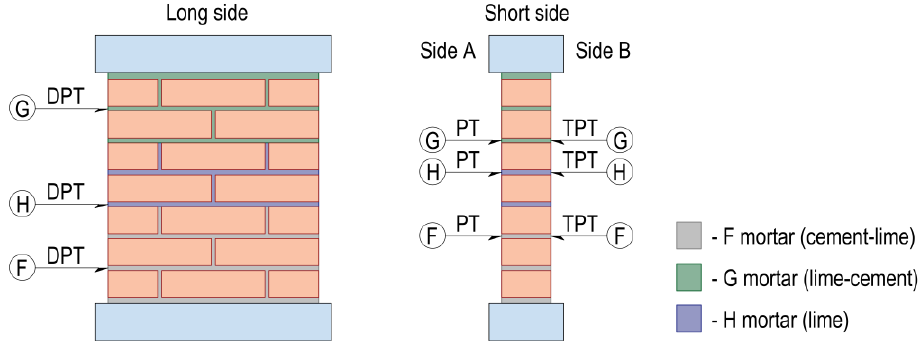
Figure 5. Construction of brick masonry prisms prepared for testing. All bed joists were tested. Three joists were dedicated to the DPT tests. The PT tests were conducted on the remaining bed joints on one side (A) of the masonry prism. The same bed joints, but on the opposite side (B) of the prism, were intended for the TPT tests.